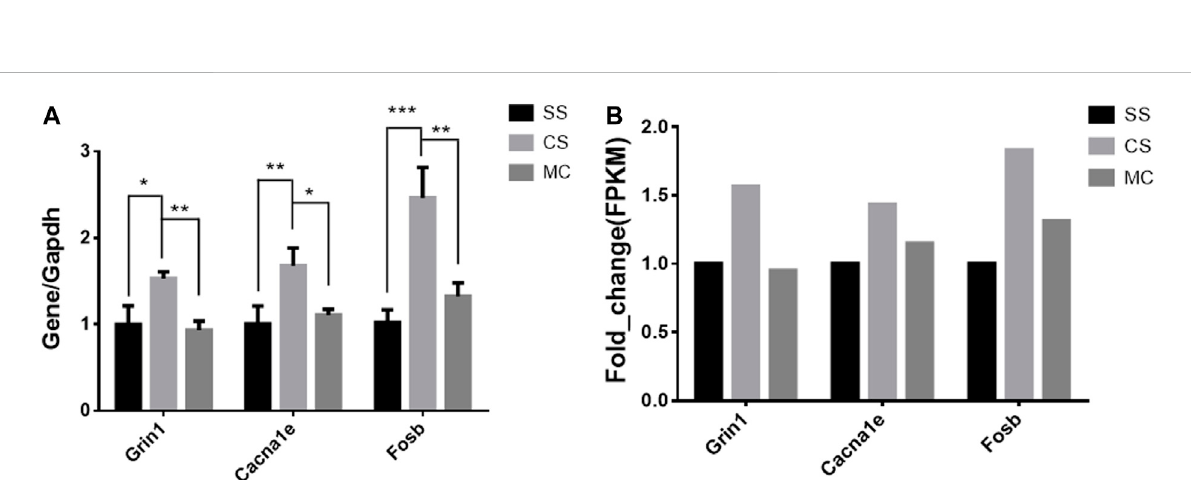
FIGURE 9 qPCR expression levels of cocaine and MET target genes. (A) Normalized mRNA expression quanti fi ed by RT-qPCR for genes (Grin1, Cacna1e, and Fosb) whose expression is altered by cocaine treatment (CSvsSS) and reversed by MET (MCvsCS). The results represent the means ± SD of three measurements